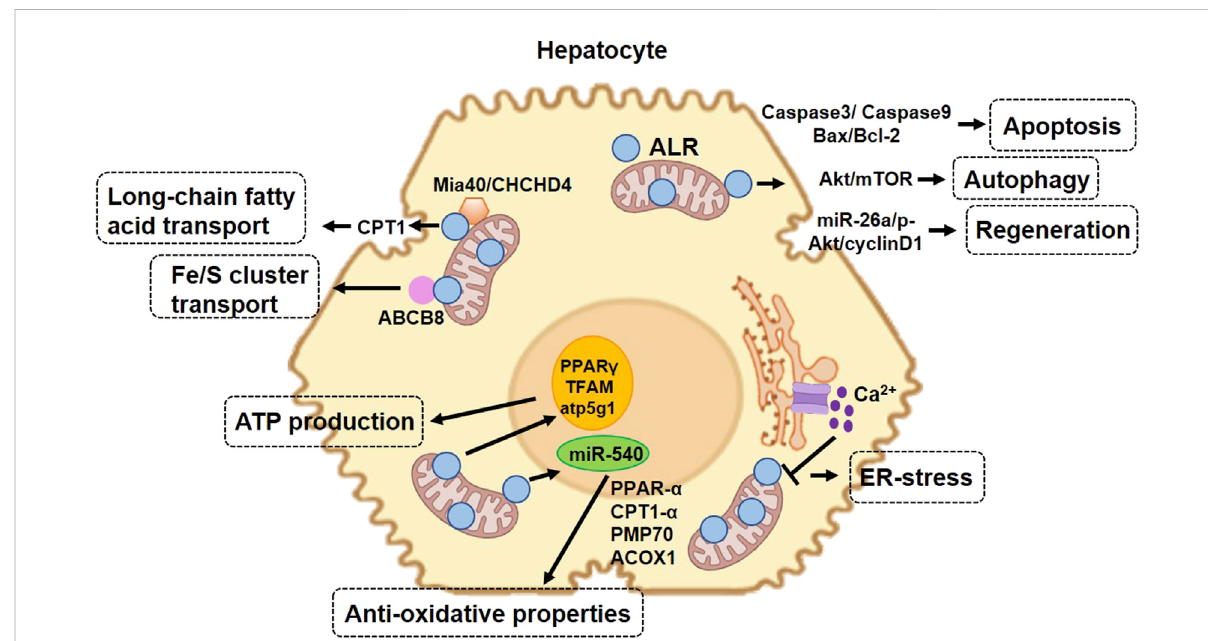
FIGURE 3 Protective role of augmenter of liver regeneration (ALR) in hepatocytes in non-alcoholic fatty liver disease. 23-kDa ALR is located in the intermembrane space of mitochondria and regulates hepatocyte function through different mechanisms. In the aspect of mitochondrial homeostasis, ALR upregulates the expression of CPT1, increasing the transport of long-chain fatty acids into mitochondria. In the aspect of anti- oxidative stress, ALR cooperates with Mia40 ensuring the adequate folding of IMS-proteins during import and export to IMS and functioning in mitochondria.ALR binds to ABCB8 andplays arole in Fe/S cluster transport. In addition, ALR suppresses theexpressionofmiR-540, which increases theexpressionofseveralproteinsinvolvedinanti-oxidativestress.ALRalsopromotescellproliferationandliverregenerationandmaintainsstemcell “ stemness ” and survival. Overexpression of ALR decreases the expression of caspase-3, thereby decreasing cell apoptosis. CPT1, carnitine palmitoyl transferase-1;IMS,mitochondrialintermembranespace;Mia40,mitochondrialimportandassemblyprotein40;CHCHD4,coiled-coil-helix-coiled- coil-helix domain-containing 4; PPAR- α , peroxisome proliferator-activated receptor alpha; PMP70, peroxisomal membrane protein 70; ACOX1, acyl-CoA oxidase 1; Fe/S, iron/sulfur clusters; ABCB8, ATP-binding cassette B8; miR-540, microRNA 540; TFAM, mitochondrial transcription factor